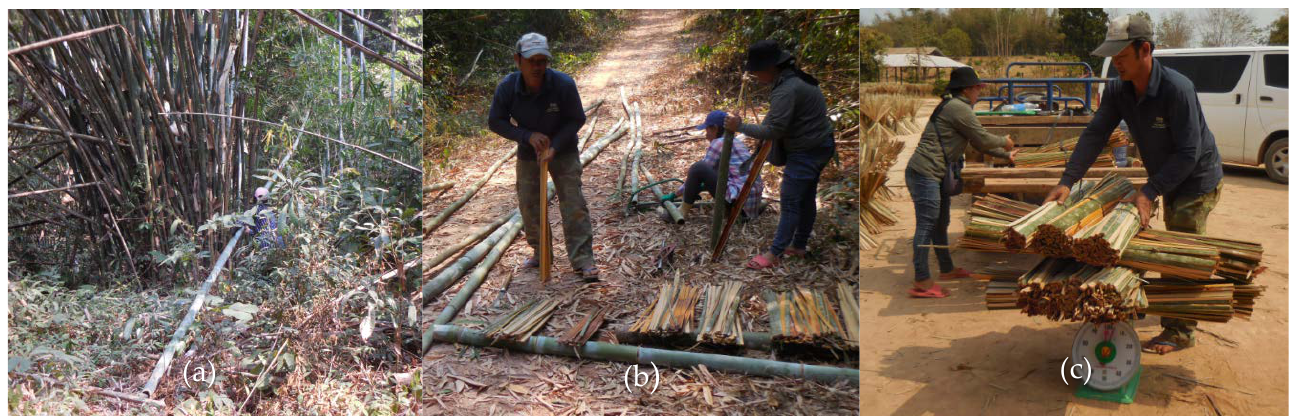
Figure 3. Bamboo harvesting and semi-processing steps: ( a ) villagers harvested whole bamboos in forest, ( b ) villagers cut and split bamboo stems (internodes) into smaller pieces on-site, and ( c ) villagers sold bamboo splits by weight to a company at the collecting area in town.